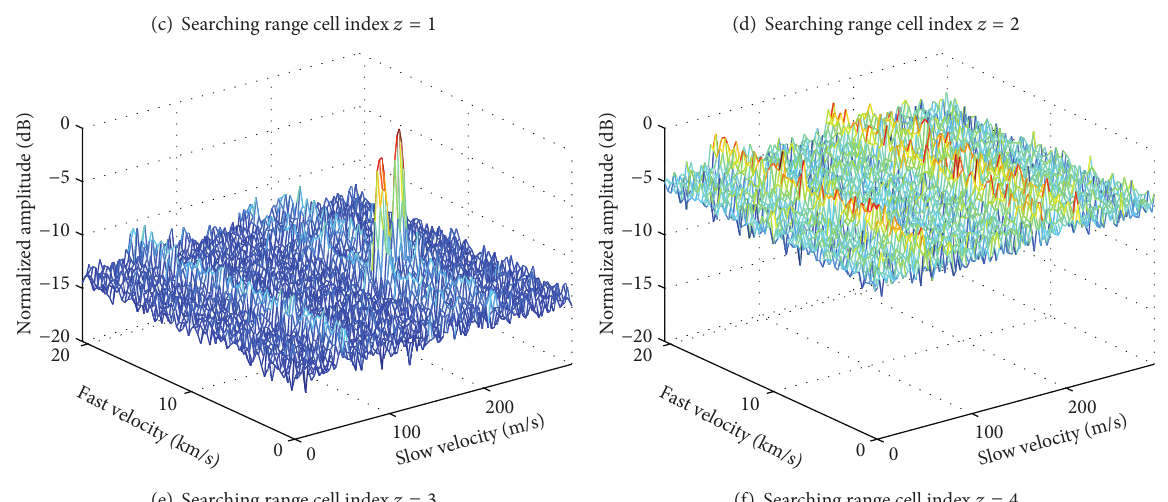
Figure 2: Results of 2D Fourier transform of the multiplied